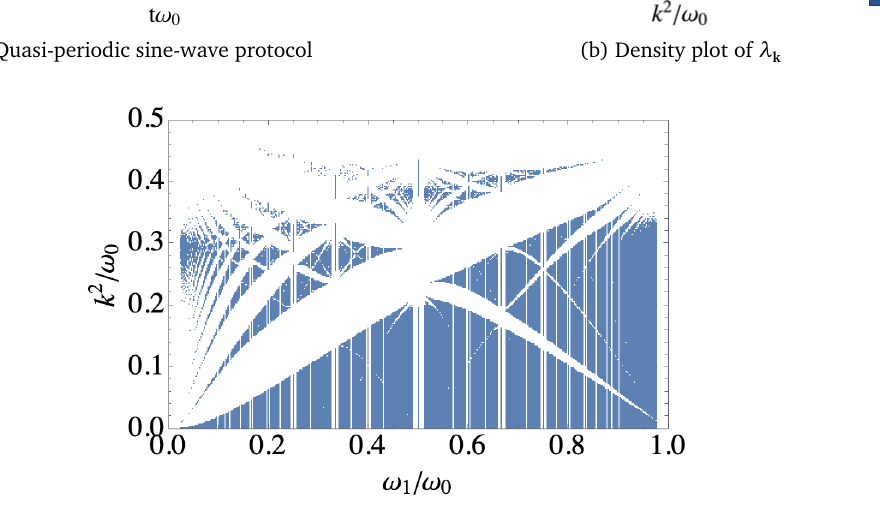
(c) Butterfly for sine-wave protocol Figure 7: (a). The quai-periodic sine wave modulation of the scattering length. Here (cid:112) 5 − 1 / g = 0.2 and ω /ω = we set g . (b). A density plot of λ 1 0 1 0 2 (cid:112) 5 − 1 /ω = . (c) The non-heating parameters for g and ω 1 0 2 /ω = 0.1. We consider all rational ω /ω = p / q with q (cid:182) g n 1 0 0 1 0